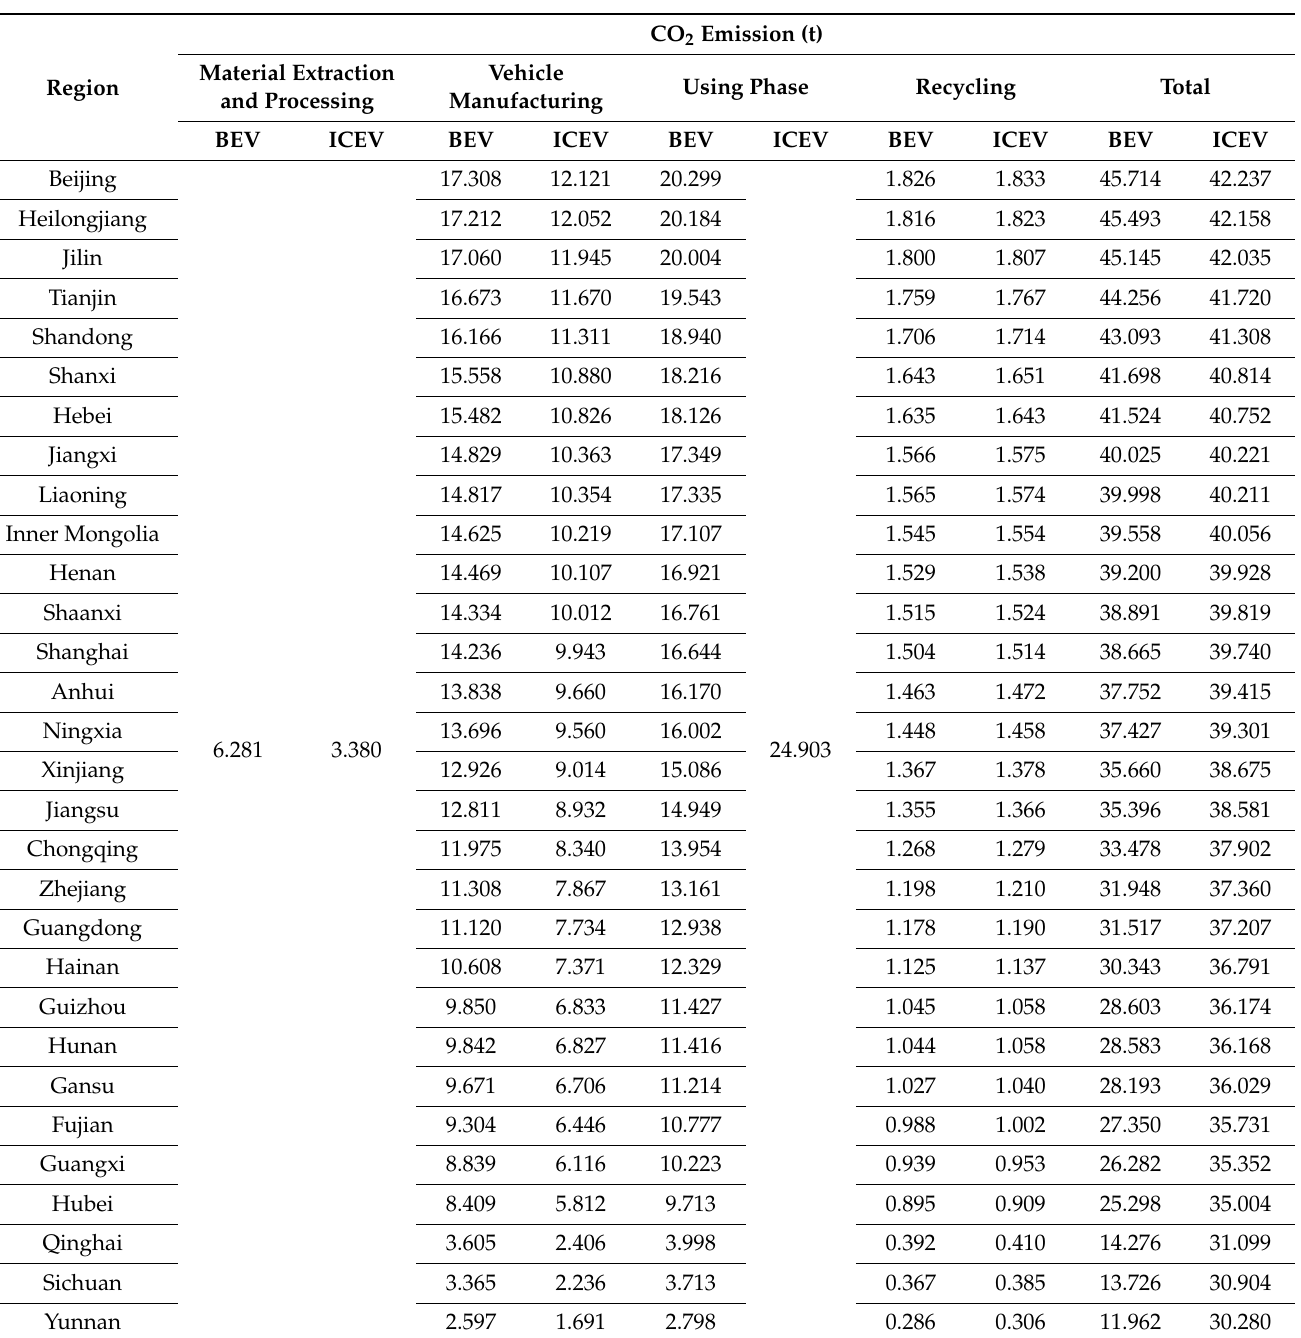
Table 6. Comprehensive comparison of life cycle CO 2 emissions between a BEV and ICEV in different regions of